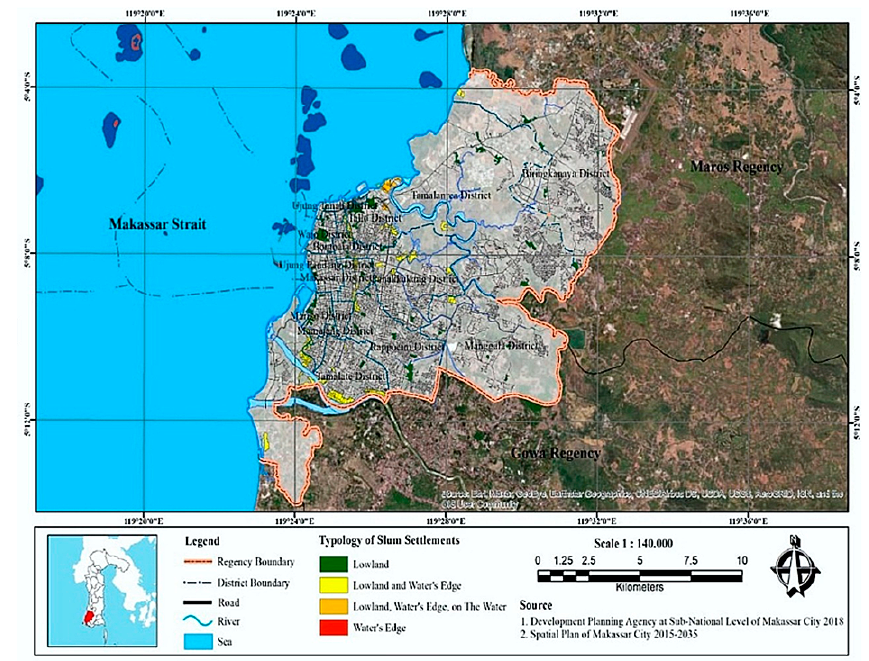
Figure 1. The location of the slum settlements in Makassar City as the object of